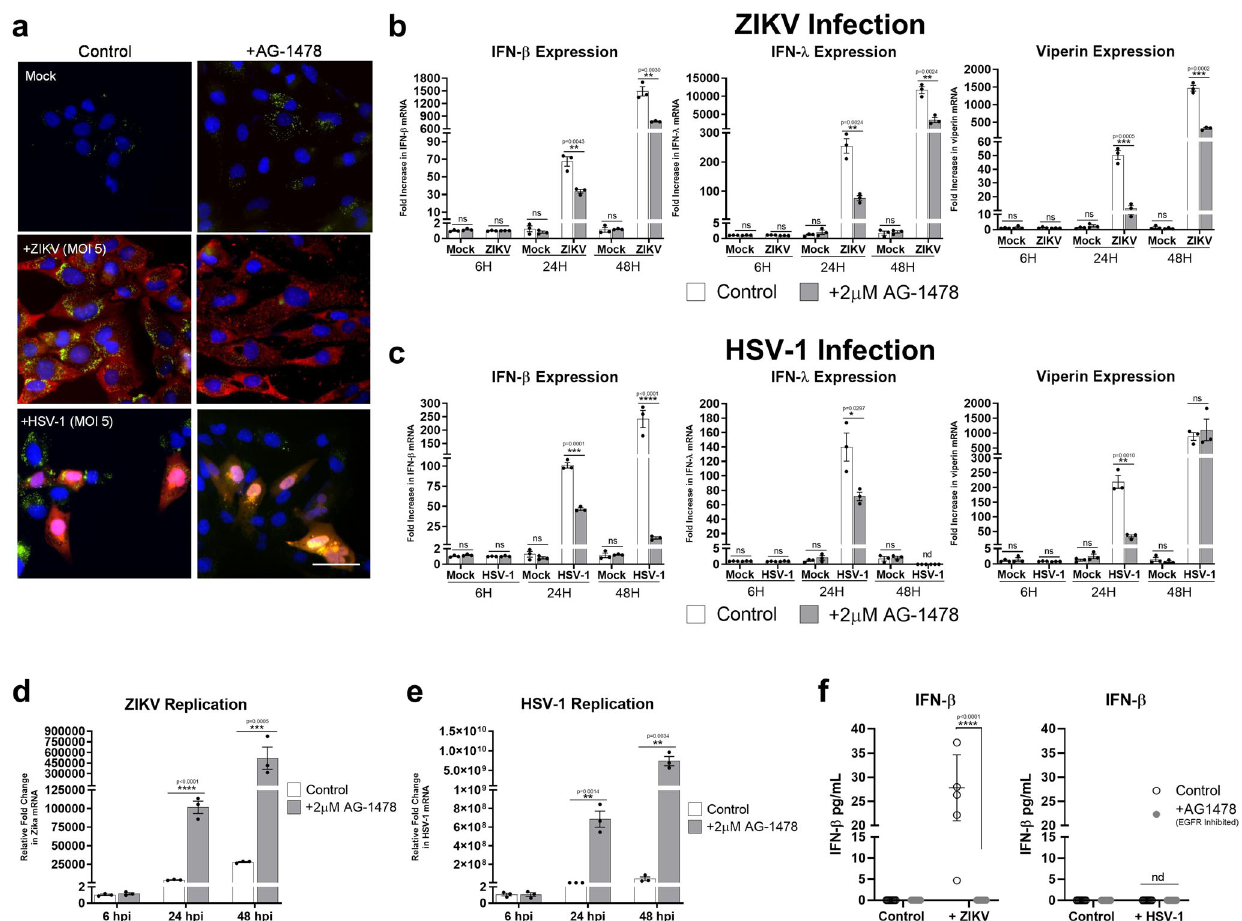
Fig. 8 EGFR treatment enhances viral infection and dampens the interferon response to ZIKV and HSV-1. a Primary immortalised astrocyte cells were treated with 2 μ M AG-1478 (EGFR inhibitor) for 16 h prior to infection with ZIKV and HSV-1. Cells were stained with Bodipy (493/503) to visualise LDs (green) and DAPI to visualise the cell nuclei (blue). ZIKV RNA was detected using anti-3G1.1 and 2G4 dsRNA antibodies and HSV-1 was detected using the anti-HSV-1 antibody (Abcam, ab9533), both viral proteins shown with red staining. Images are a representation of n = 3 independent experiments. b , c RT- qPCR was utilised to evaluate IFN- β , IFN- λ and viperin mRNA expression at 8, 24 and 48 hpi for both ZIKV at MOI 0.1 or HSV-1 at MOI 0.01. RT-PCRs were performed to detect viral nucleic acid levels of ( d ) ZIKV and ( e ) HSV-1. In ( b – e ) error bars, mean values± SEM, P values were determined by unpaired two- tailed Student ’ s t test with a Holm-Sidak correction for multiple comparisons for 2 or more groups (greater than 300 cells; n = 3 biological replicates). Stimulated cells were statistically compared with their respective mock controls, ns = not signi fi cant. f IFN protein levels from these experiments were analysed via ELISA for IFN- β and IFN- λ protein at 16 h post infection. Error bars, mean values ± SEM, P values were determined by two-way ANOVA post- hoc pairwise comparisons with Bonferroni correction ( n = 3 biological replicates), nd = not detected. Source data are provided as a Source Data fi